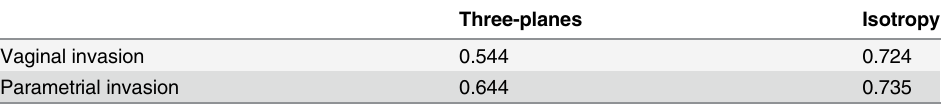
Table 8. Inter-reviewer consistency ( k